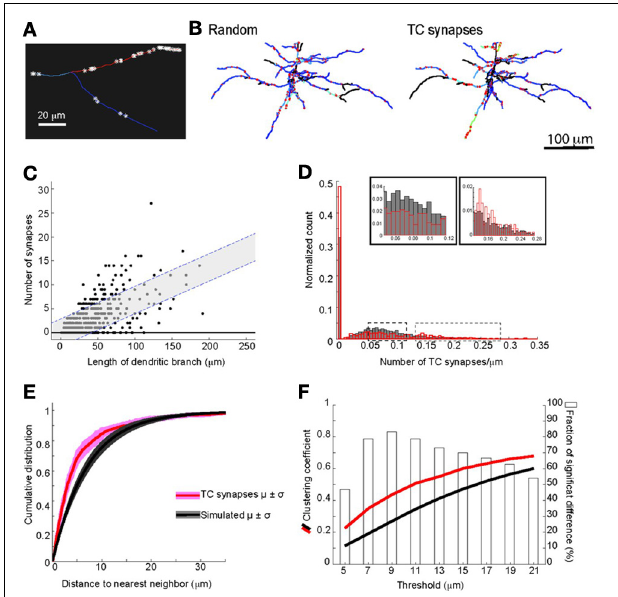
FIGURE 9 | Clustering of TC input on dendrites of L5 pyramidal neurons. (A) Example of dendritic branches of the same L5 pyramidal cell (from dotted box in Figure 4B ) showing different densities of TC synapses. (B) Examples of basal dendrites from simulated random synapses and the experimentally observed TC synapse distribution for the same neuron. The location of synapses is indicated by the red stars, synapse density for each branch is color-coded; view is from above (scale bar = 100 µ m). (C) The relationships between length of dendritic branch and number of TC synapses onto L5 basal dendrites. Shaded areas with dashed lines denote 95% confidence intervals from simulated randomly distributed synapses of L5 basal dendrites. (D) Histogram of TC synapse density for all dendritic branches from all reconstructed neurons. Insets: expansions of peak and tail of the distribution as indicated by the dashed boxes. (E) Averaged cumulative distributions for nearest neighbor distances of TC synapses from L5 basal dendrites, for experimental data (red, eight reconstructed neurons) and for simulations of 8000 model neurons with randomly distributed synapses (black). (F) The mean clustering coefficient for TC synapses at various spatial thresholds from basal dendrites of all eight reconstructed neurons (red line) and for simulated randomly distributed synapses (black line). Bars (right y-axis) show statistical results using a KS test to determine the fraction of simulations there are significantly different from the experimental data set of whole neurons (open bars) or of L5 basal dendrites.